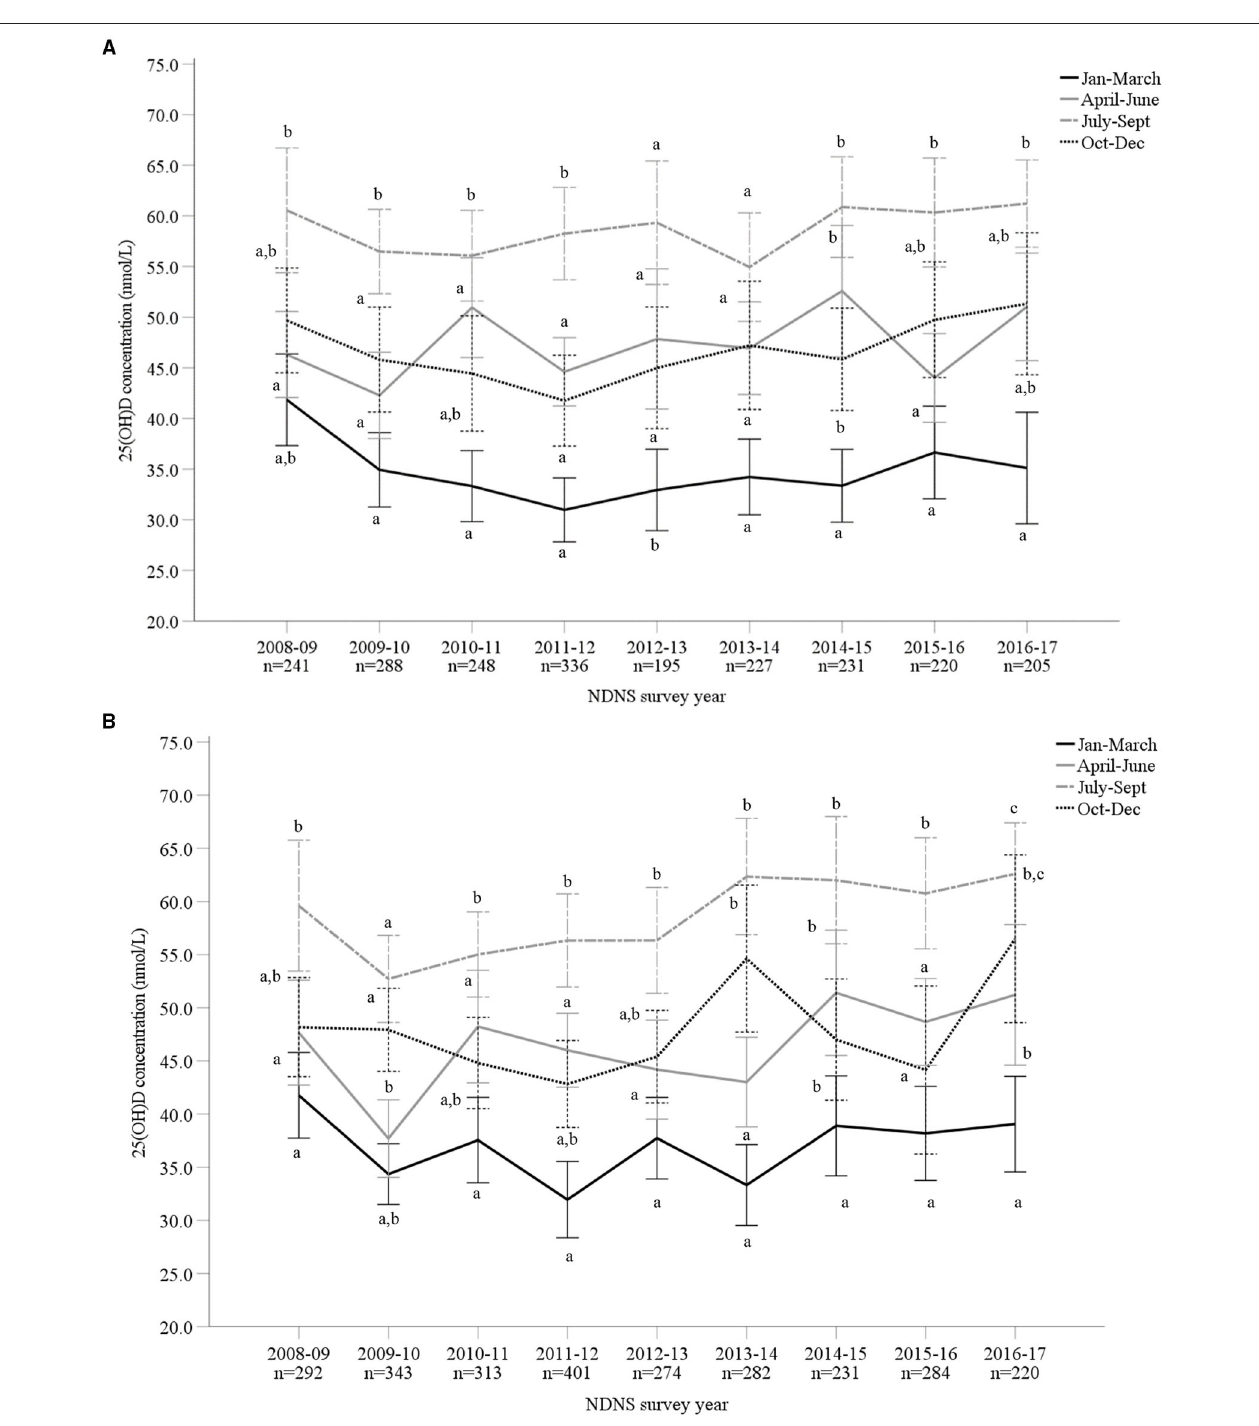
FIGURE 3 | (A,B) Vitamin D status [25-hydroxyvitamin D (25(OH)D) nmol/L] of male ( A ; n = 2,191) and female ( B ; n = 2,640) adults aged 19–64 years from Years 1–9 (2008–2017) of the UK National Diet and Nutrition Survey (NDNS; total n = 4,831). Data is presented as mean (95% CI). Values not sharing a common superscript letter (a, b, c) are significantly different ( p < 0.05) between seasons in each survey year; one-way ANOVA and post-hoc (Tukey) tests. 25(OH)D concentration data from standardized liquid chromatography coupled to tandem mass spectrometry (LC-MS/MS). UK, United Kingdom; n , number of participants; CI, confidence interval.